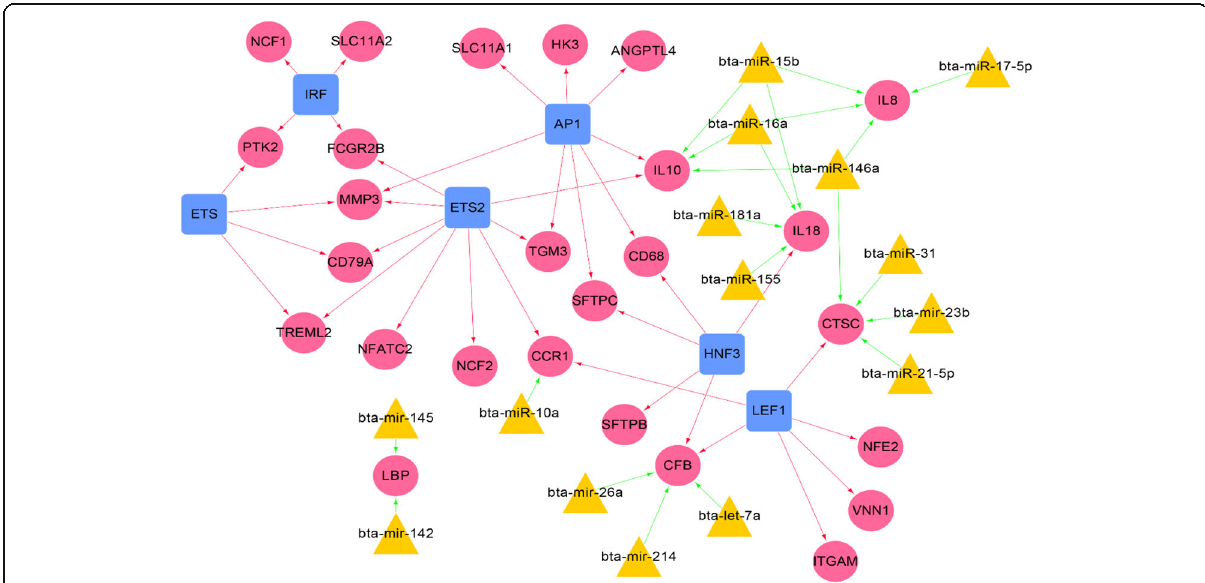
Fig. 3 miRNA-DEG-TF regulatory network. Red rounded nodes represent DEGs, yellow trigonal nodes represent miRNAs, and blue quadrate nodes represent significantly related TFs; red arrow lines mean TF-DEGs regulatory relationships, green arrow lines mean miRNA-DEGs regulatory